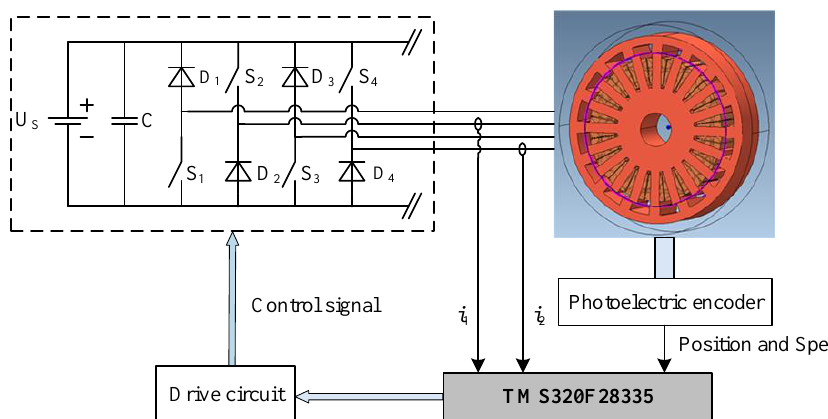
Figure 10. Five-phase 20/16 pole OSRM structure block diagram of the speed regulation